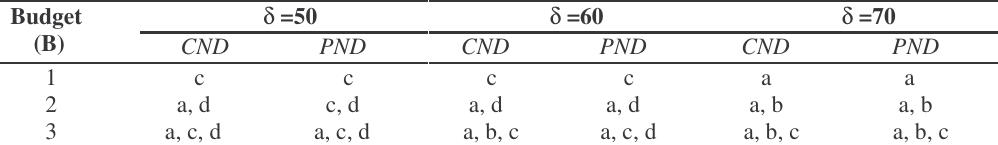
Figure 4. A numerical example for the PND